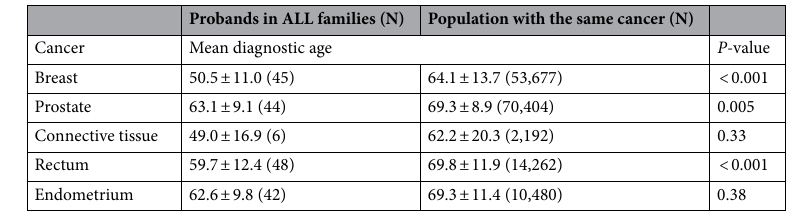
Table 3. Mean diagnostic age in cancers in probands of ALL families and in the population.